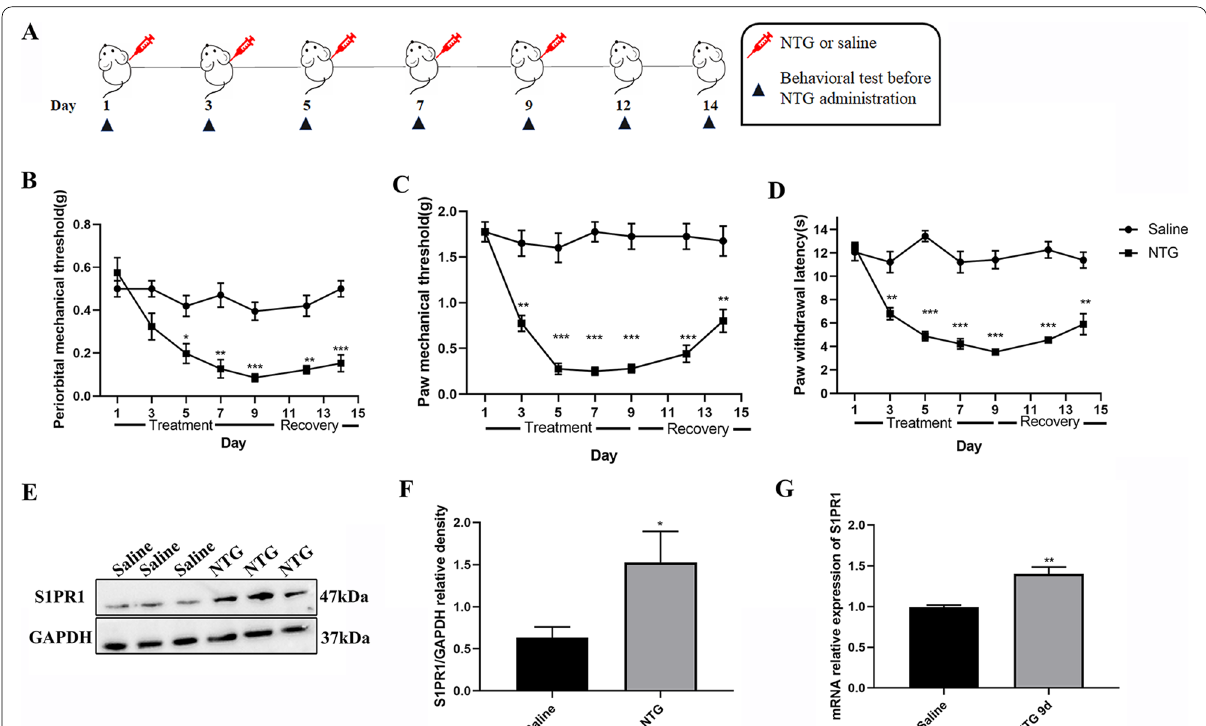
Fig. 1 Upregulation of S1PR1 expression at mRNA and protein levels after chronic NTG injection. A Timeline of NTG or saline administration and behavioral testing. B‑D Compared with the Saline group, the mechanical pain thresholds of periorbital in the NTG group gradually decreased from fifth day ( n 8/group, * p < 0.05, vs Saline); the mechanical and thermal pain thresholds of hindpaw in the NTG group gradually decreased from third = day ( n 8/group, ** p < 0.01, vs Saline); * p < 0.05, ** p < 0.01 and *** p < 0.001 compared with the Saline group. E, F The expression of S1PR1 at protein = level increased in the TCC following NTG injection for 9 days ( n 6/group, * p < 0.05, vs Saline). G The mRNA relative expression of S1PR1 increased in = the NTG (9d) group compare with the Saline group ( n 6/group, ** p < 0.01, vs =